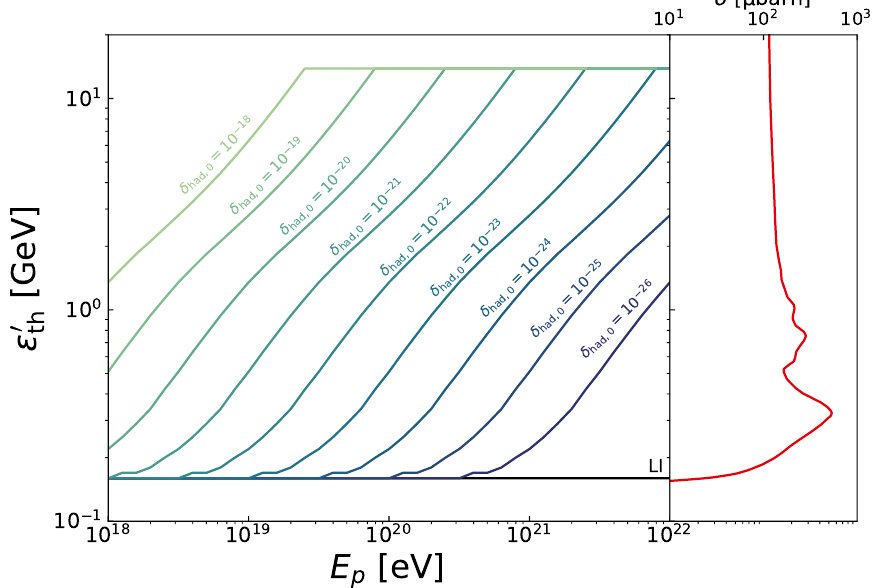
Figure 7. Energy threshold in the proton reference frame for the pion production. The black line shows the results for a LI assumption, while the different colored lines show the results for differ- ent LIV coefficients. The right panel shows the cross-section for that given energy, based on the parameterizations from